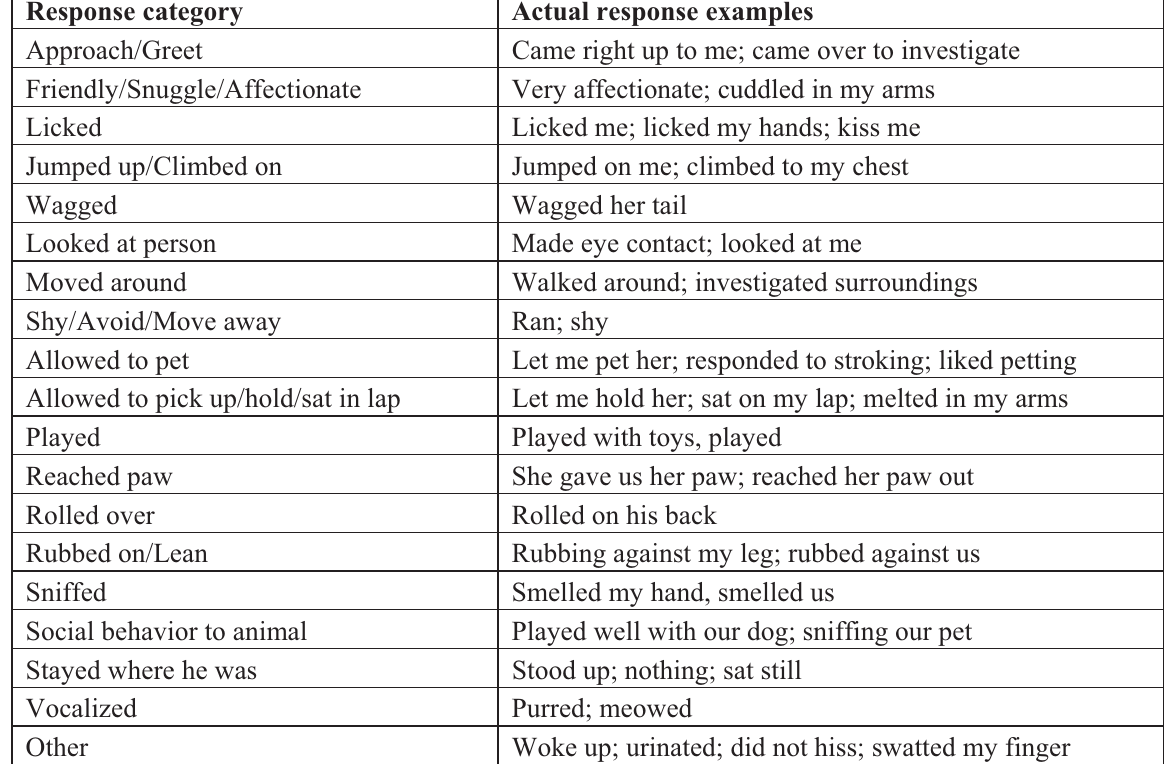
Table 2. Categories and typical responses for Question 3, “What did this pet do when you first met